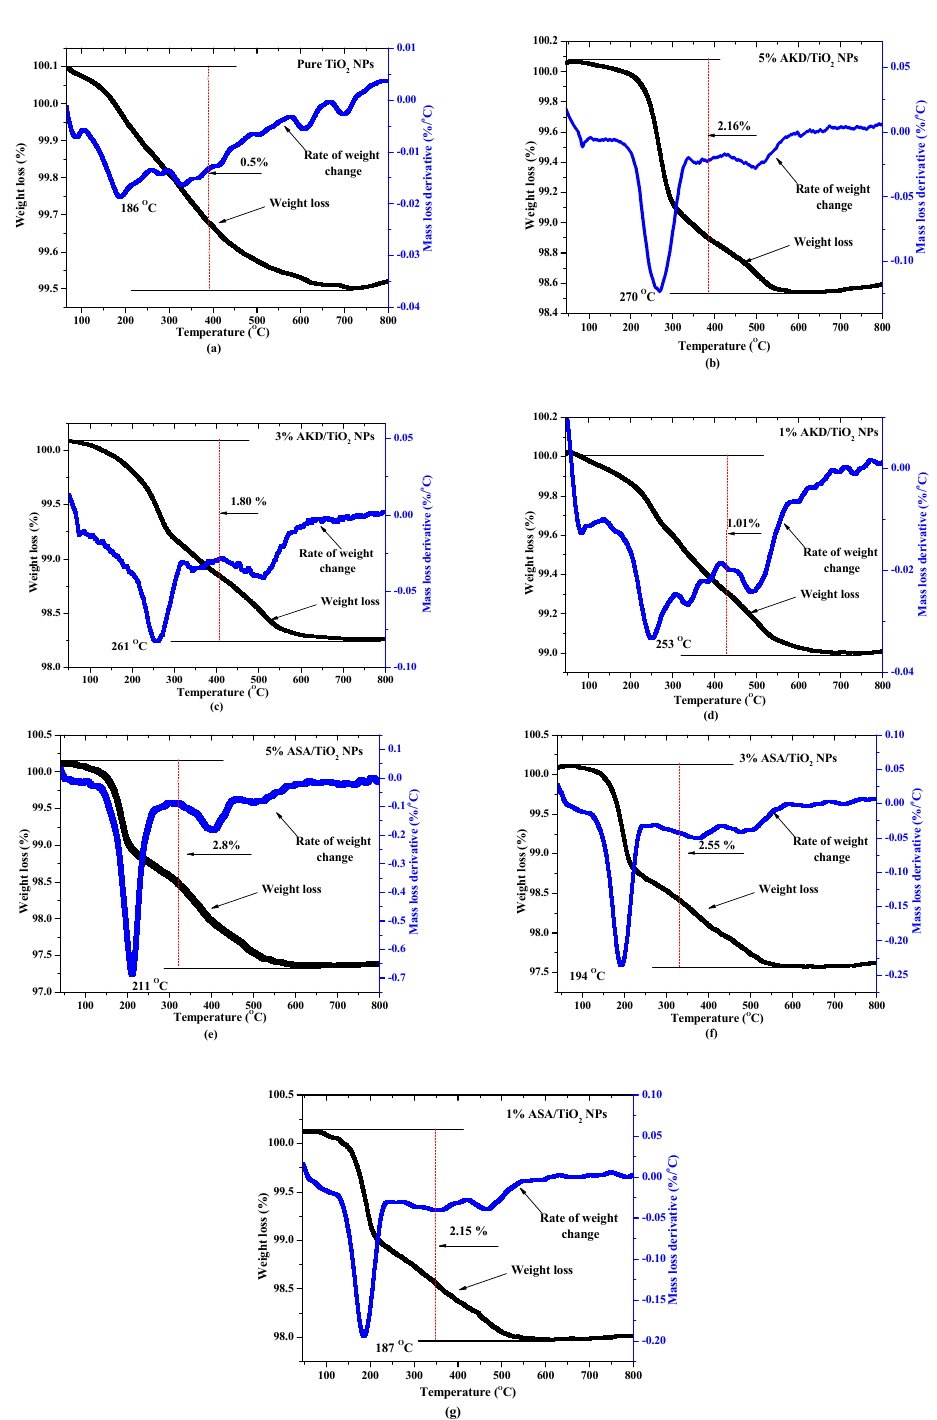
Figure 10. Thermogravimetric analysis graph: ( a ) pure TiO2 NPs; ( b ) 5% AKD/TiO 2 NPs; ( c ) 3% AKD/TiO 2 NPs; ( d ) 1% AKD/TiO 2 NPs; ( e )5% ASA/TiO 2 NPs; ( f ) 3% ASA/TiO 2 NPs; ( g ) 1% ASA/TiO 2 NPs. Table 3. Effects of surfactant content and type on thermal stability.